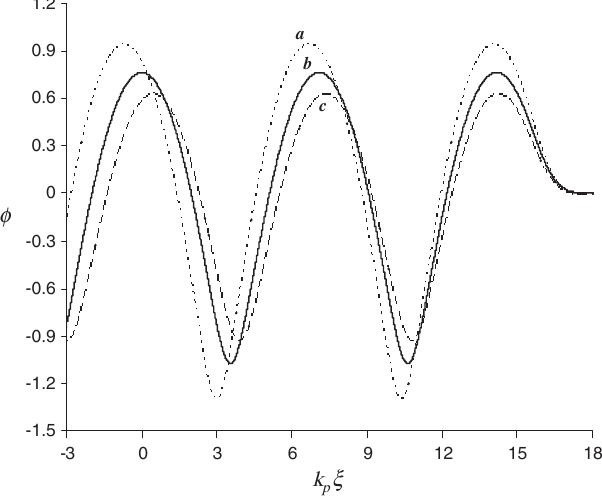
FIG. 1. Variation of normalized longitudinal electrostatic po- (cid:5) for (cid:1) ¼ (cid:4) 1 (curve a ), (cid:1) ¼ 0 (curve b ), and tential ð (cid:7) Þ with k p ¼ 32 (cid:9) m , and L ¼ 7 : 2 (cid:9) m (cid:1) ¼ þ 1 (curve c ) for a 0 ¼ 1 : 0 , (cid:8) p